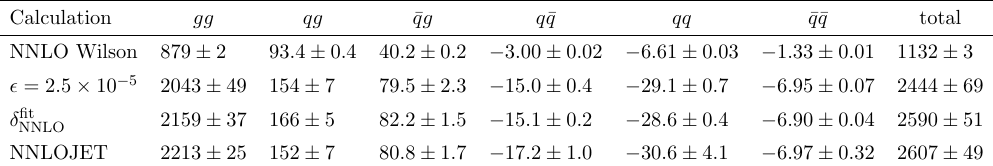
Table 3 . Comparison between MCFM and NNLOJET results for the NNLO coe(cid:14)cient (cid:14) NNLO , de(cid:12)ned in eq. (3.2), in the YR4 setup detailed in the text. We also show separately the NNLO Wilson coe(cid:14)cient contribution to (cid:14) NNLO . Results are shown for the boosted de(cid:12)nition of T 1 , for (cid:15) = 2 : 5 (cid:2) 10 (cid:0) 5 and also for the (cid:12)t values ( (cid:14) (cid:12)t ). Note that the total column includes a factor of two NNLO for channels that are not beam-symmetric and uncertainties on individual channels are combined linearly in the